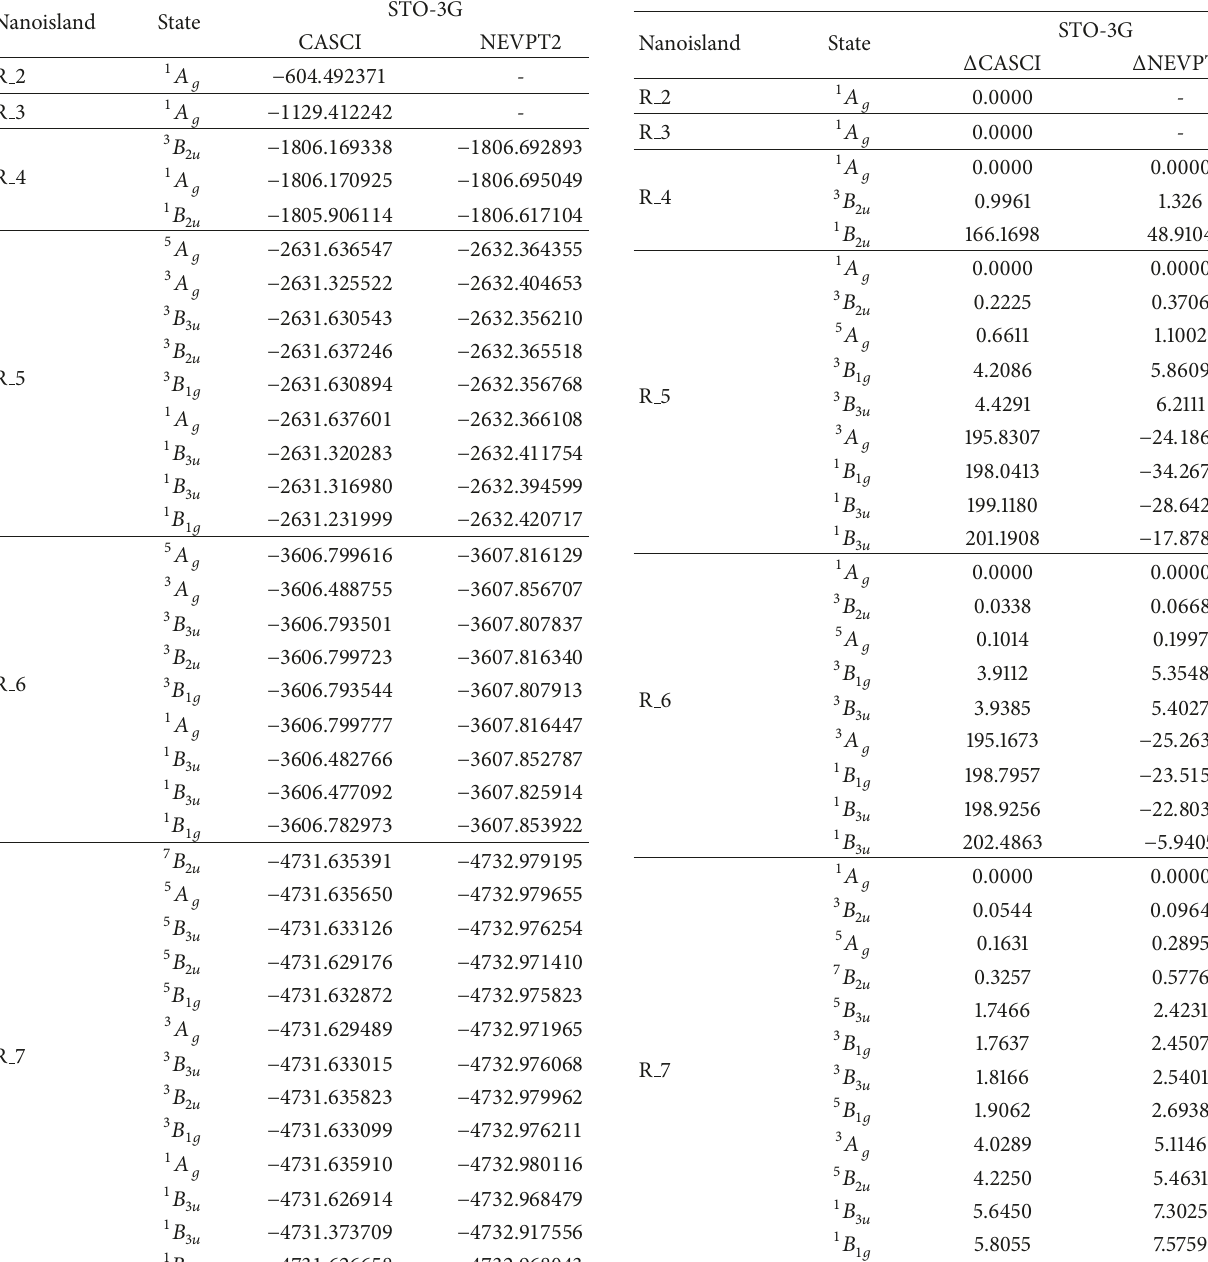
Table 8: Energy differences for the different rhombus nanoislands in